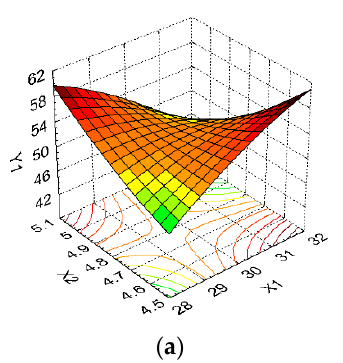
Figure 4. Plot showing correlation between the expected normal values and residuals for ( a ) WCW (g/L), ( b ) DCW (g), ( c ) CA (°), ( d ) PC (%), and ( e ) DS (%).